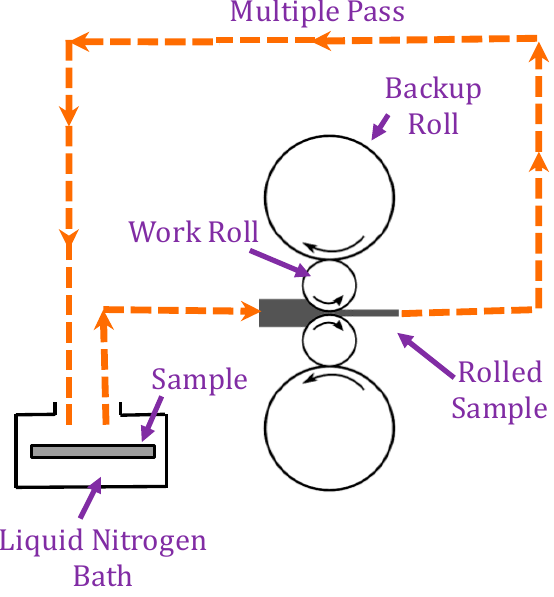
Figure 1. Schematic of the cryo-rolling operation.